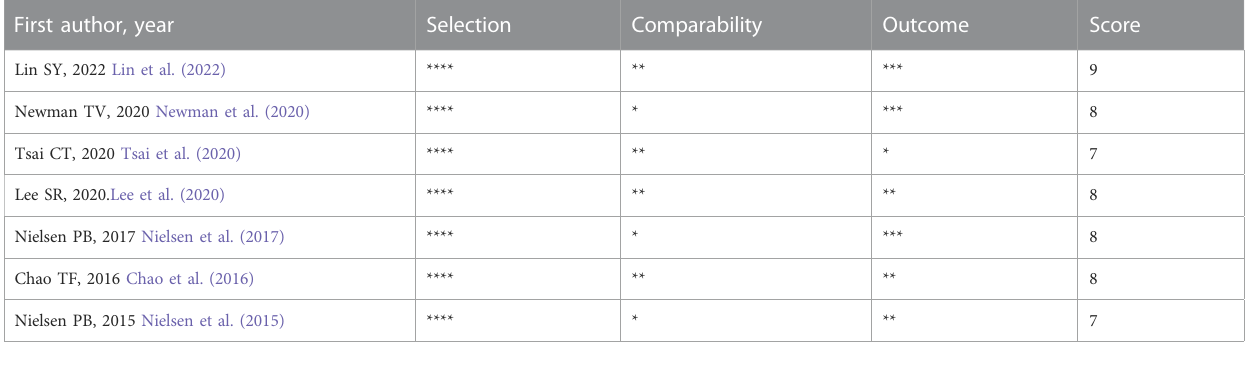
TABLE 2 Quality assessment results of cohort studies.